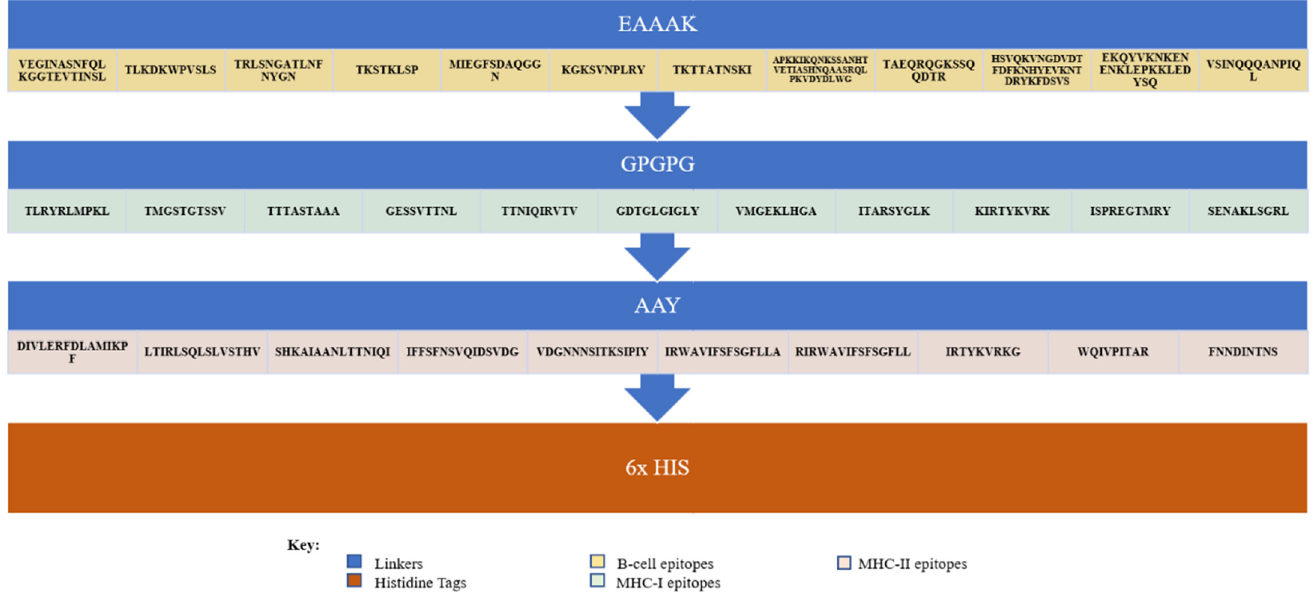
Figure 2. The vaccine construct, with linkers EAAAK in between the B-cell epitopes, GPGPG in between the MHC-I epitopes, AAY in between the MHC-II epitopes, and 6x His tag in the end.